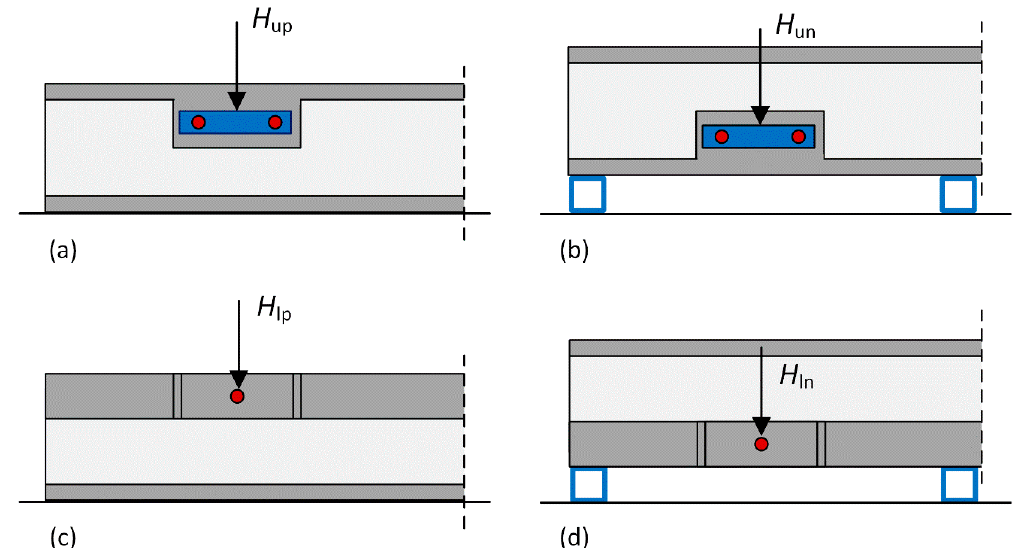
Figure 6. Schematic of the shear load capacity test set-ups; ( a ) positive shear load at upper anchors ( H up ), ( b ) negative shear load at upper anchors ( H un ), ( c ) positive shear load at lower anchors ( H lp ) and ( d ) negative shear load at lower anchors ( H ln ). Red filled circle indicates loaded bolt anchors.